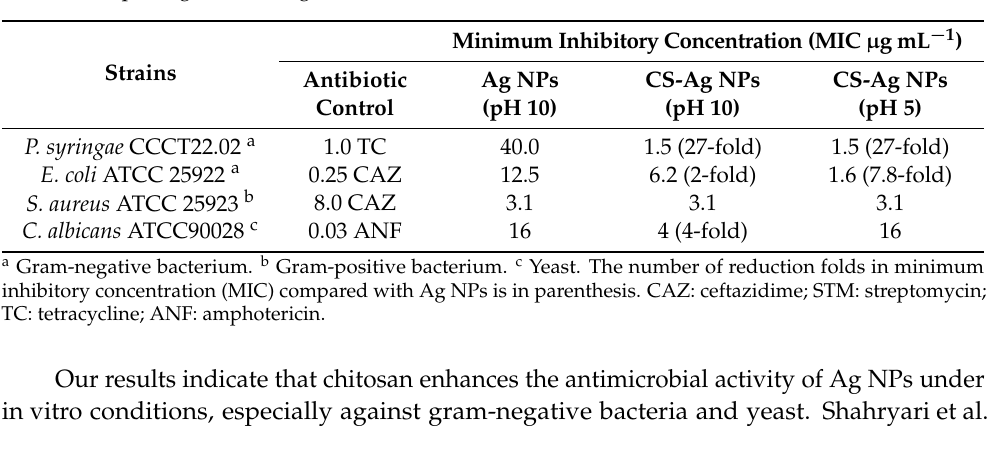
Table 1. The minimum inhibitory concentration of synthesized nanomaterials against phytopathogen and human pathogen